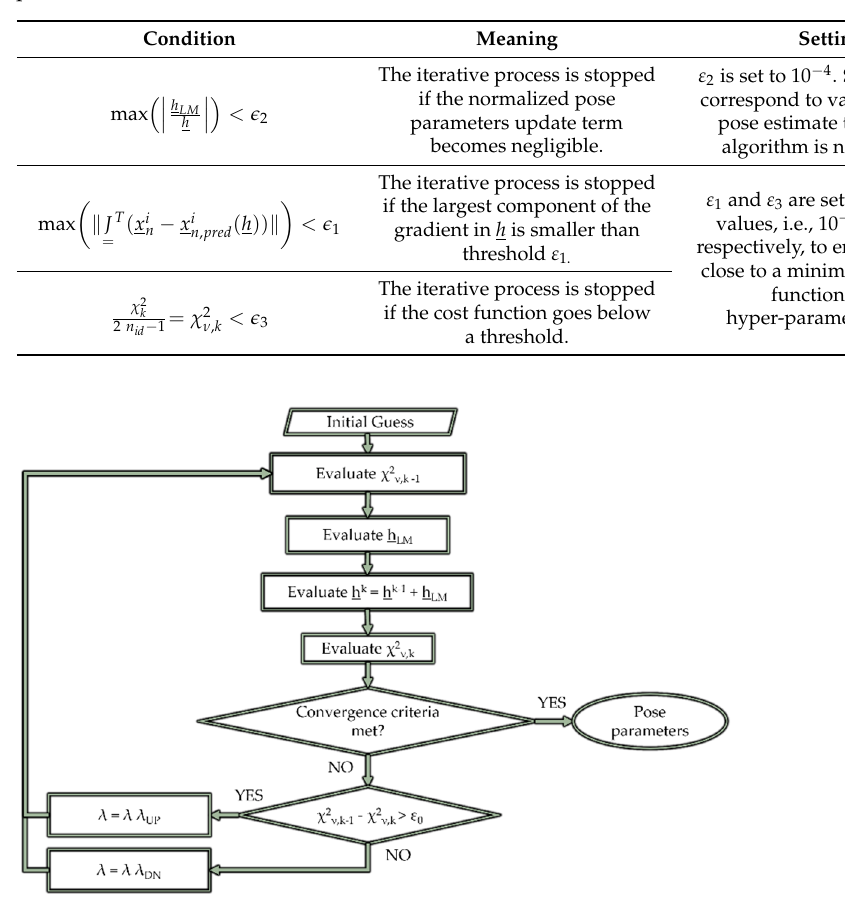
Figure 8. Flow chart for the proposed implementation of the Levenberg–Marquardt’s iterative method for the least squares non-linear estimation of the pose parameters.